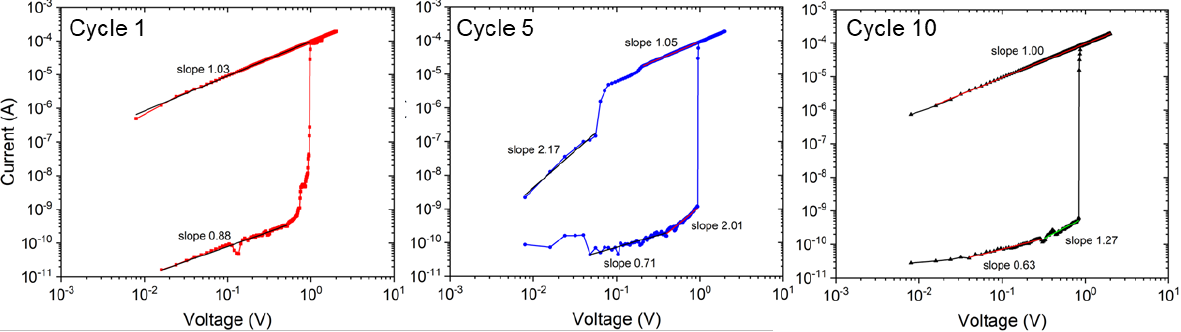
Figure 7. ( a ) Typical I – V curve of the Au/NaFeHCF/Ag layer sequence. The inset shows the used measurement geometry. ( b ) I – V curves of Au/NaFeHCF/Ag layers at different cycle numbers. The bias voltage range was +2.0 V to − 2.0 V.